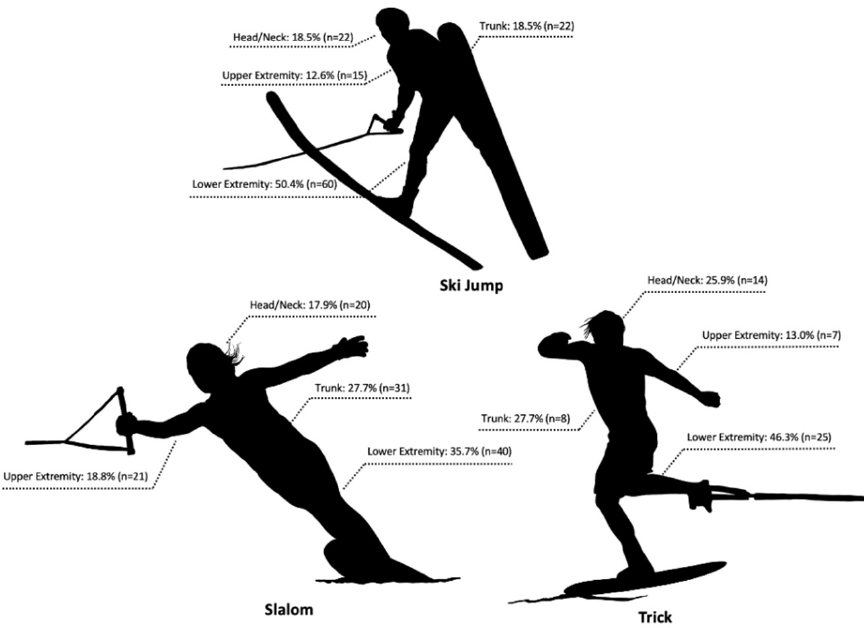
Figure 1. The distribution of body parts injured by 3-event water skiing.